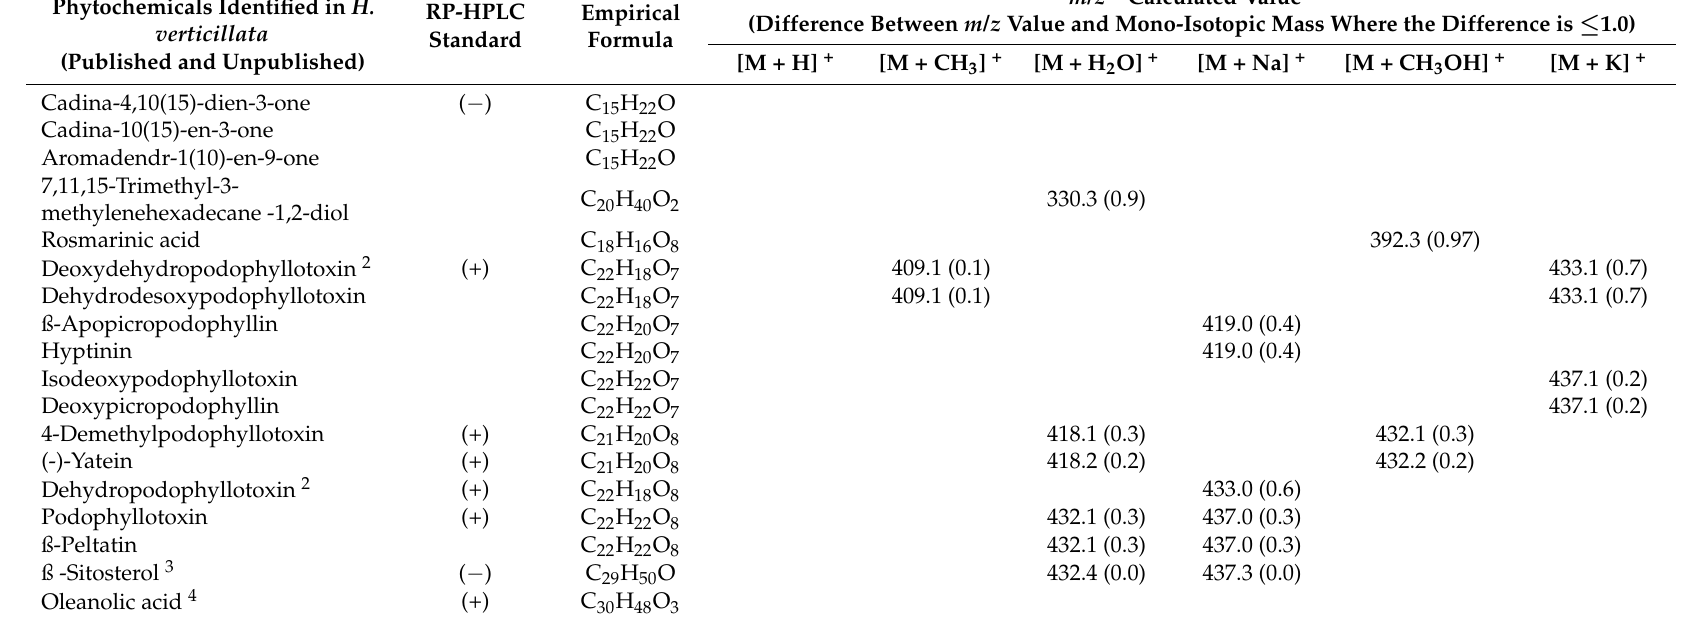
Table A1. LC-MS and HPLC analysis and